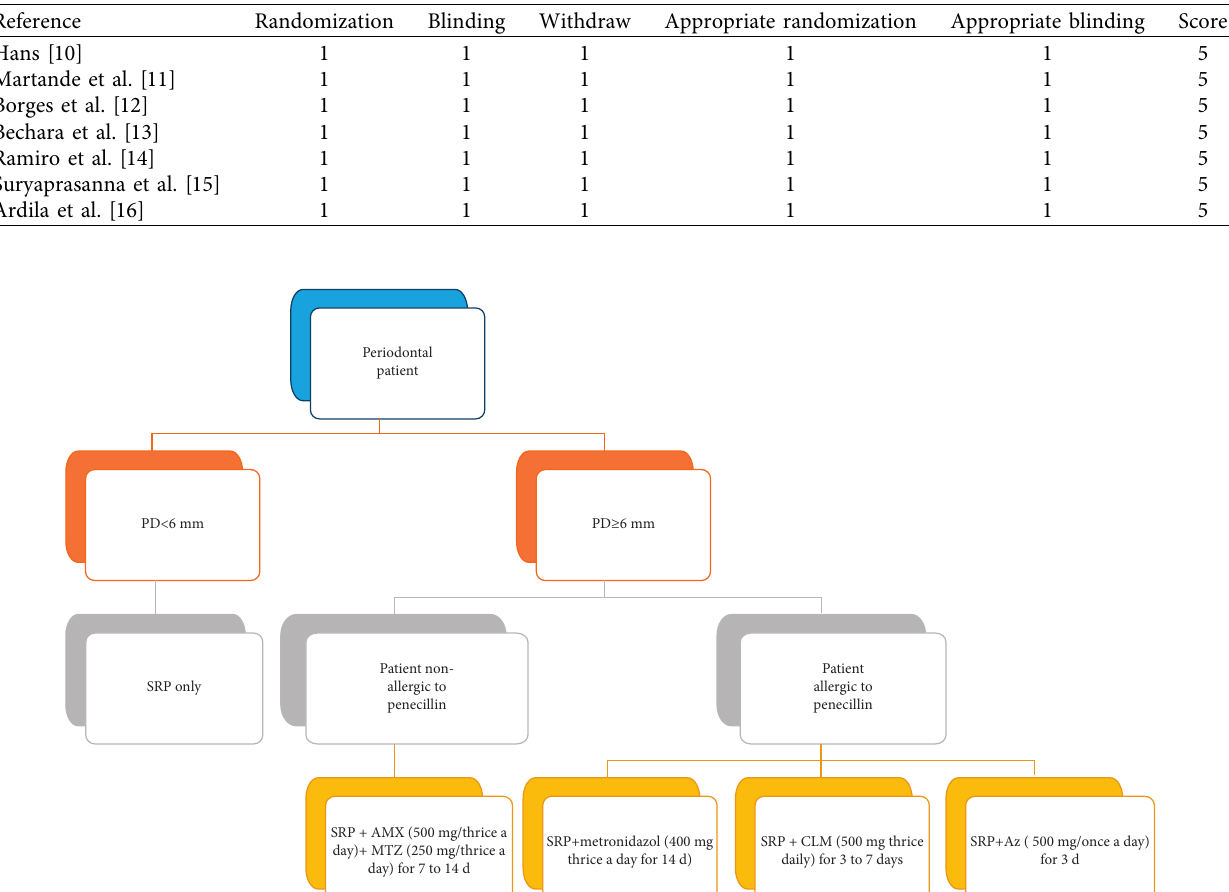
Table 2: Jadad scores scale [6].